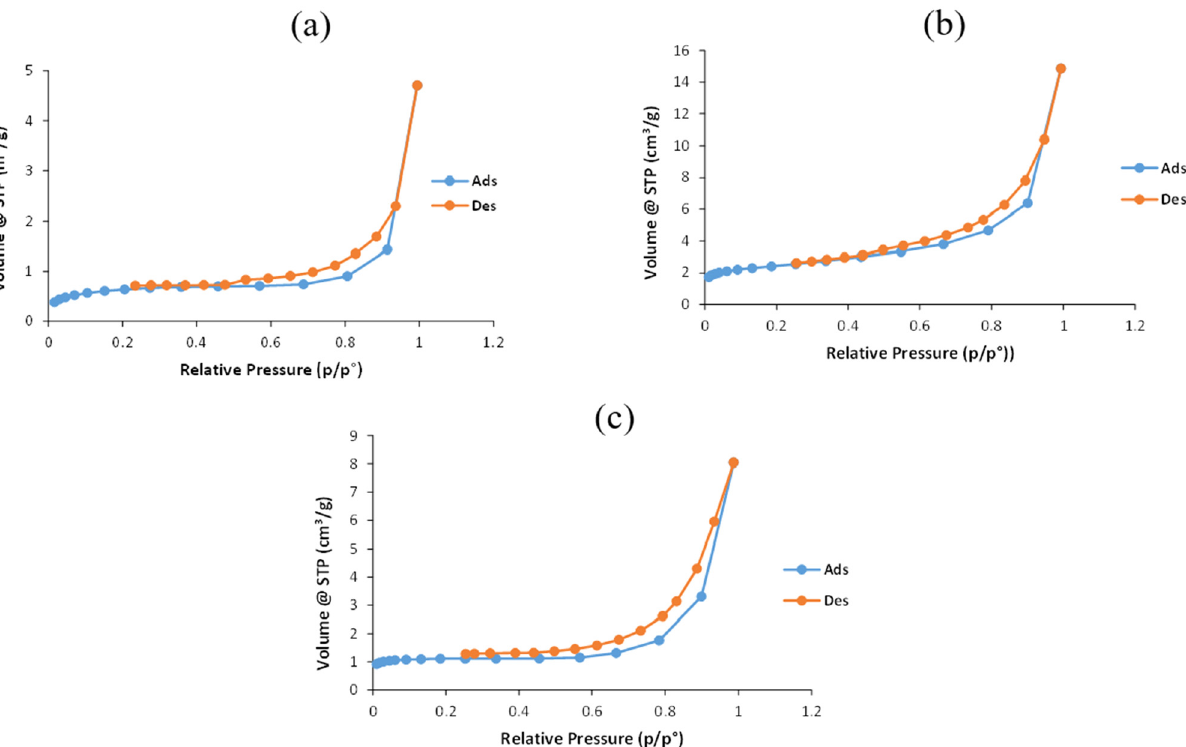
Figure 7: N 2 adsorption – desorption isotherms of Bi/CA composites prepared with ( a ) 8 mmol, ( b ) 24 mmol, and ( c ) 32 mmol